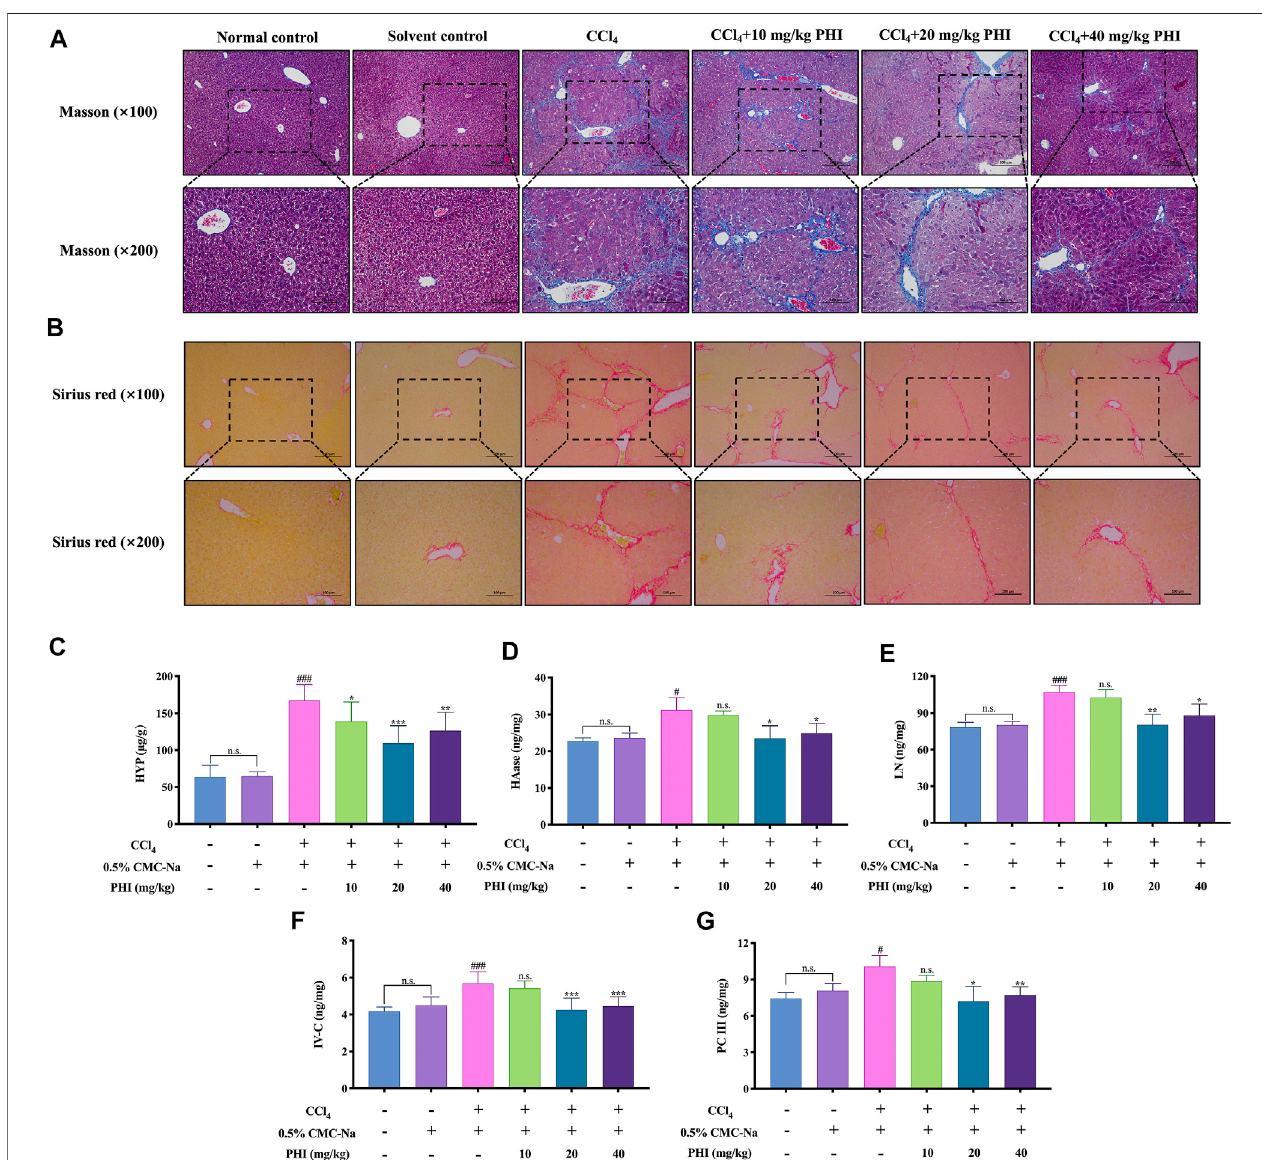
FIGURE3| EffectofPHI oncollagendepositionandliverbiochemicalindexesofliver fi brosisinmice. (A) Massonstaining( × 100and × 200). (B) Siriusred staining ( × 100 and × 200). (C) Liver HYP activity. (D) Liver HAase activity. (E) Liver LN activity. (F) Liver IV-C activity. (G) Liver PC Ⅲ activity. Data was expressed as the mean ± SD( n (cid:1) 6). # p < 0.05, ### p < 0.001representcomparedwithsolventcontrolgroup.* p < 0.05,** p < 0.01,*** p < 0.001representcomparedwithCCl 4 group.n.sindicates no signi fi cant.